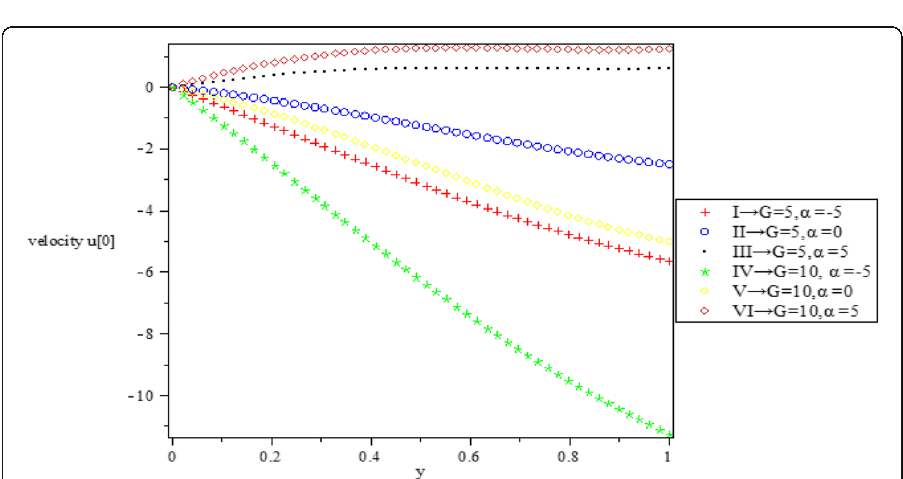
Fig. 4 Zeroth-order velocity (u[0] profile, r = 2 and β = 1.5)